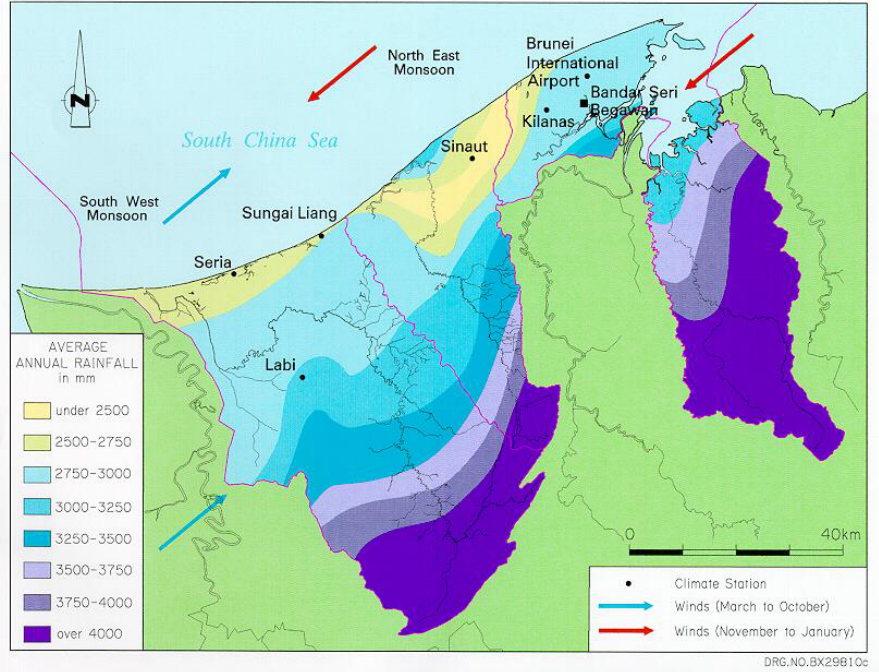
Figure 1. Map of rainfall trend in the study area [32]